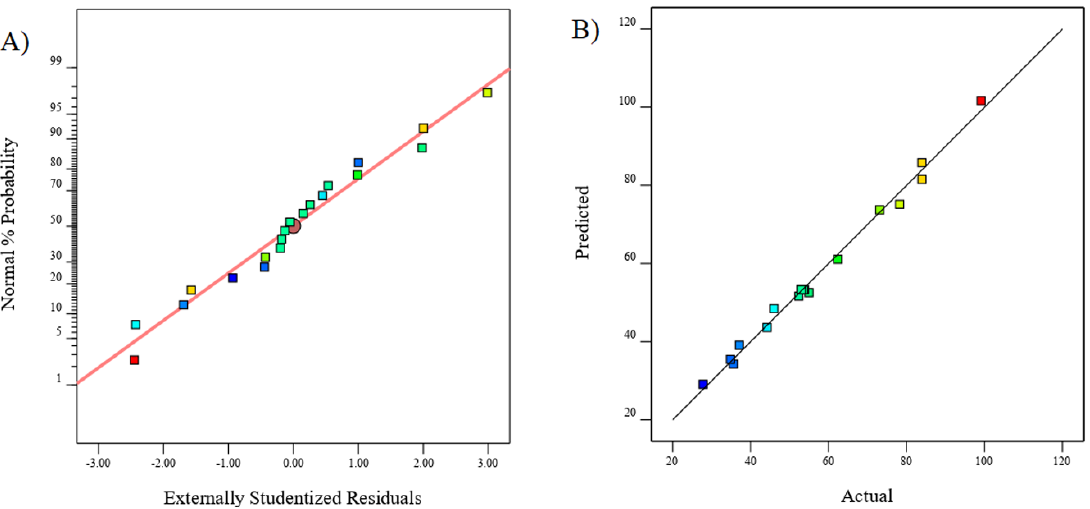
Figure 9. Diagnostics tests including ( A ) Normal probability plot and ( B ) Predicted vs. experimental D% values for the response of photocatalytic degradation of MO.